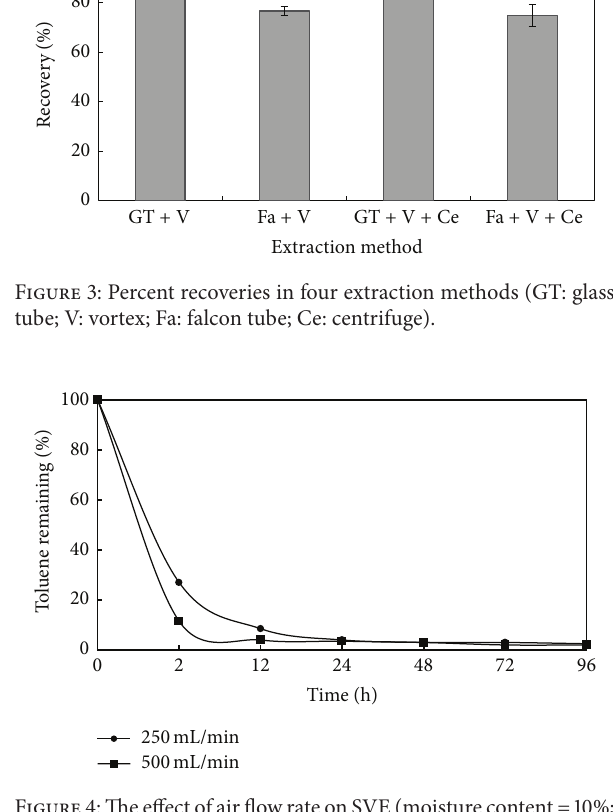
Figure 4: The effect of air flow rate on SVE (moisture content = 10%; initial toluene conc. = 2 mg/g